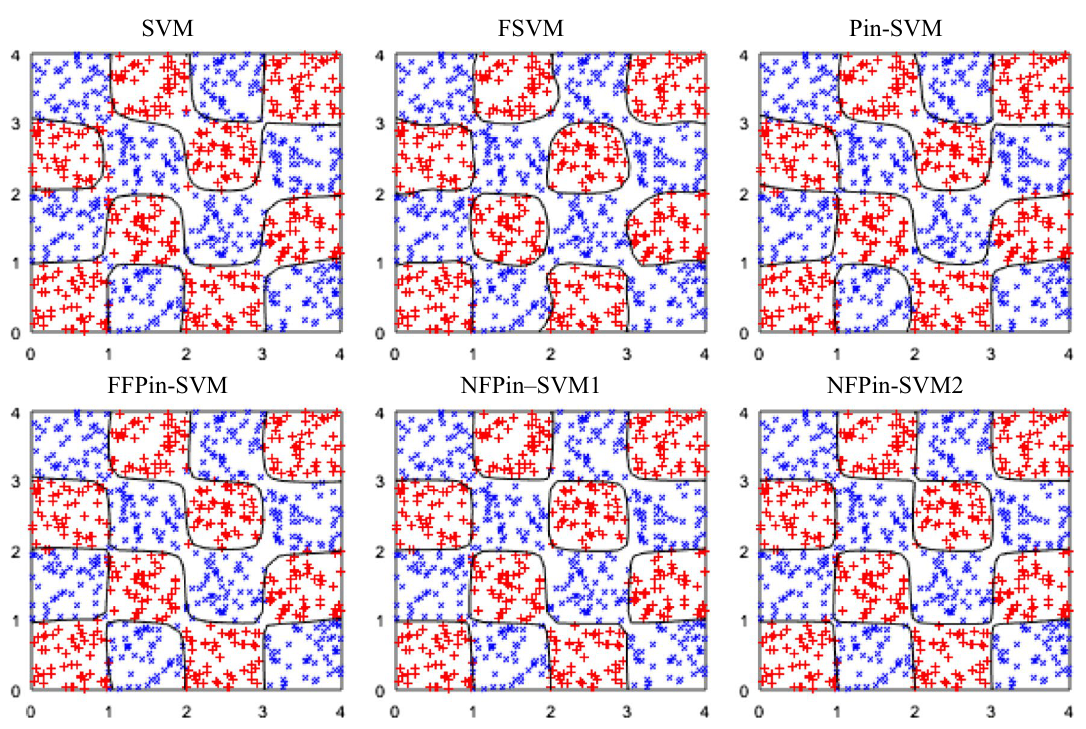
Fig. 3 Classification results of our proposed methods FFPin-SVM, NFPin-SVM1, and NFPin-SVM2 with Pin-SVM, FSVM, and SVM on Examlpe3 (synthetic Checkerboard dataset) Table 3 The performance comparison of our proposed methods nonlinear FFPin-SVM, NFPin-SVM1, and NFPin-SVM2 with nonlinear Pin- SVM, FSVM, and SVM on Example3 (Synthetic Checkerboard dataset). Time is for training in seconds FSVM SVM ( C ( C, μ ) μ , Time